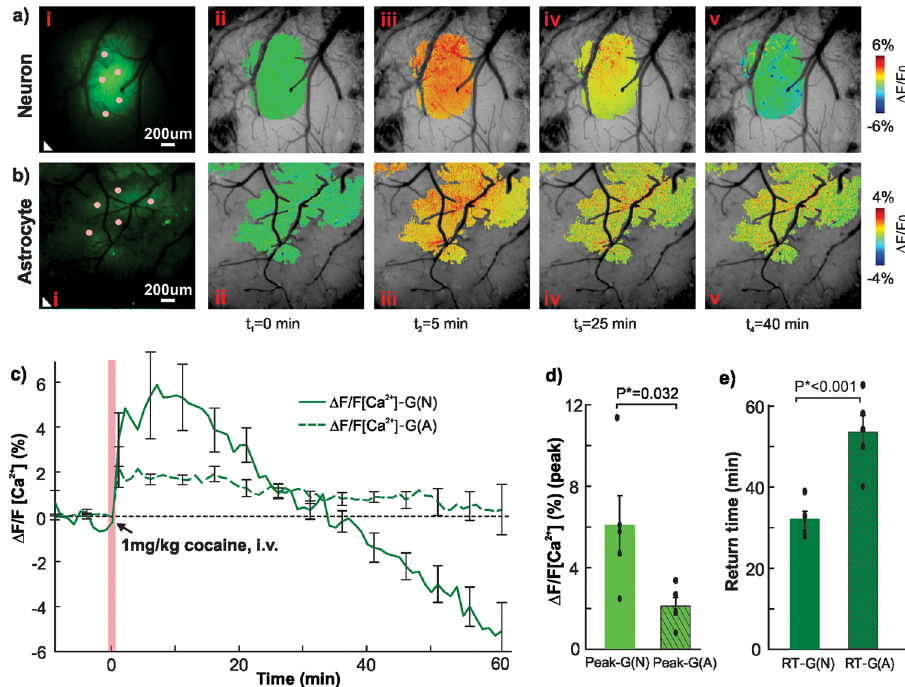
Þ and astrocytic ð Δ F = F Þ mice. a , b Time lapse Fig. 4 Cocaine-induced cellular Ca 2 + dependent fl uorescence changes in neuronal ð Δ F = F Ca 2 þ - G ð N Þ Ca 2 þ - G ð A Þ images of Ca 2 + fl uorescence ratio changes Δ F = F (ii-v) and Δ F = F (ii – v) in response to cocaine (1 mg/kg, i.v) superposed on their baseline Ca 2 þ - G ð N Þ Ca 2 þ - G ð A Þ spectral images (i) obtained at λ 1 = 568 nm. Five Regions of interest (ROIs) were selected from fl uorescence expressing regions (e.g., pink dots) and one ROI from outside expressing area (e.g., white triangle), that was used to correct for confounding artifacts. c Cocaine-induced mean Ca 2 + fl uorescence changes in neurons ( Δ F = F , solid line, n = 5), and astrocytes ( Δ F = F dash line, n = 5), both showing immediate Δ F / F Ca 2 + increases after Ca 2 þ - G ð N Þ Ca 2 þ - G ð A Þ cocaine (1 mg/kg, i.v). The Δ F = F increase was robust and returned to baseline within ~30 min, whereas the Δ F = F increase was smaller Ca 2 þ - G ð N Þ Ca 2 þ - G ð A Þ (~2%) but longer lasting. d Comparison of peak increases in Δ F = F longer lasting than the neuronal response ( p *<0.001). All error bars are presented as means ± SEM.